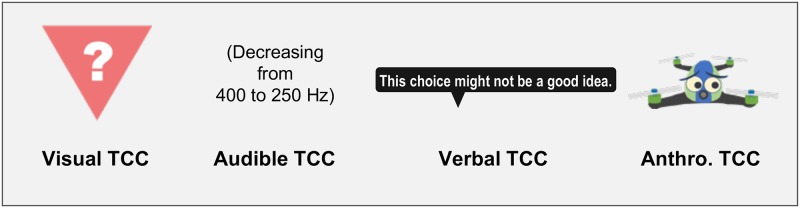
Four types of TCCs.The image of the anthro. TCC is similar but not identical to the original one used in the experiment due to a copyright reason.